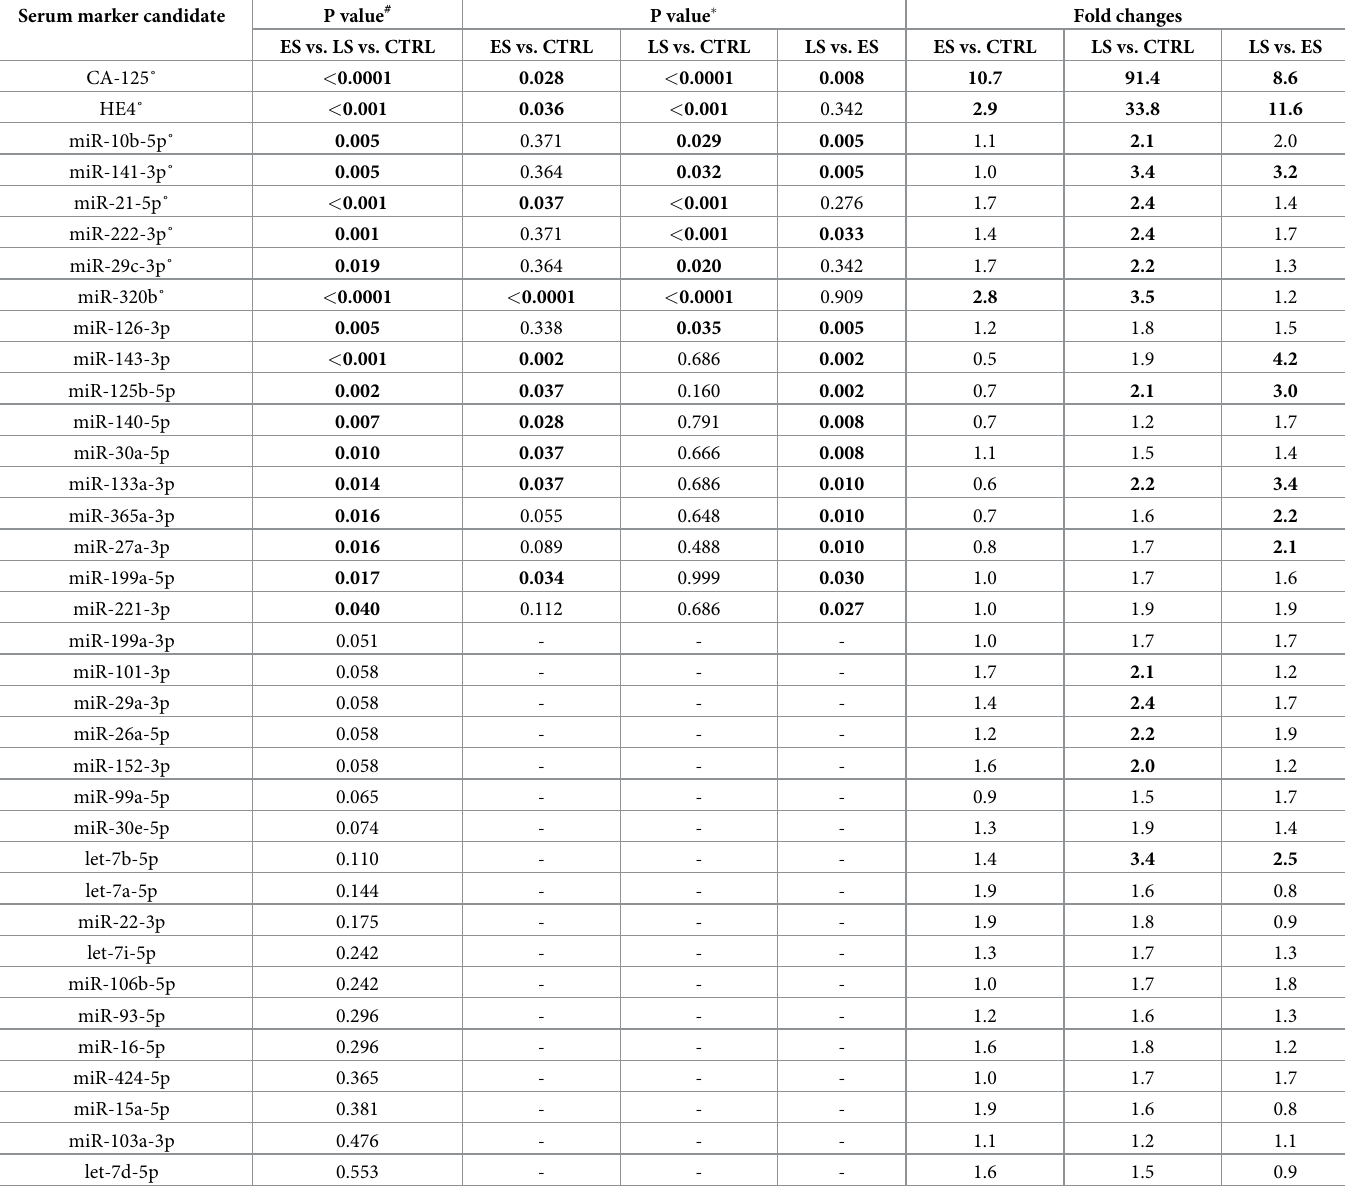
Table 2. Comparison of the ovarian cancer serum biomarkers CA-125 and HE4 and miRNAs candidates among early stage, late stage ovarian cancer patients and healthy controls groups in the Discovery Set. Serum marker